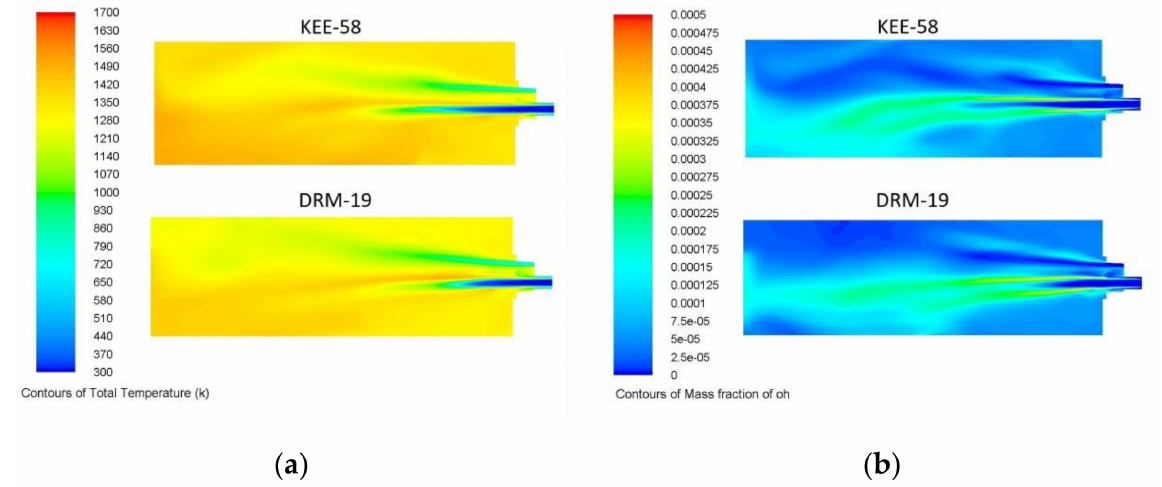
Figure 5. Comparison of the ( a ) temperatures and ( b ) OH mass fractions of the burner’s central plane for the KEE-58 and DRM-19 mechanisms with BFG as fuel and an air excess of 4%. For the assessment of the turbulence–chemistry interaction, two different approaches were followed, and both used the non-premixed combustion model. In the case of BFG and the mixtures of NG/BFG, the laminar flamelet model (LFM) was used [33]. The LFM